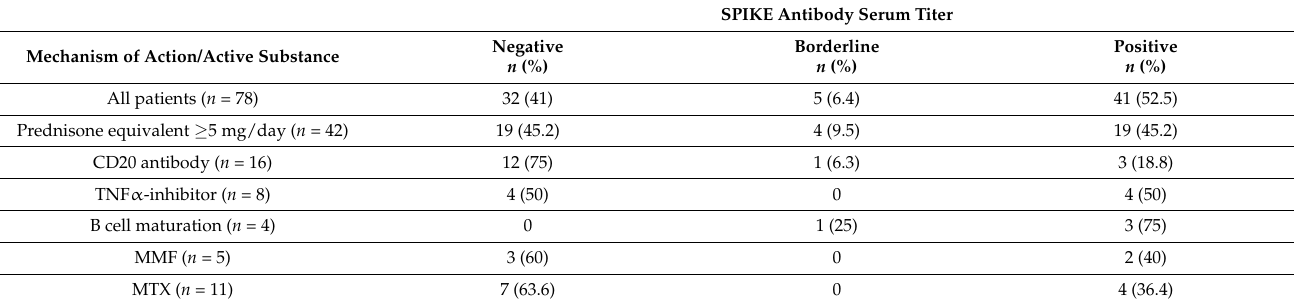
Table 2. Serostatus depending on the type of immunosuppressive therapy (SPIKE antibody serum titer: negative, IgG ratio < 0.8; borderline, IgG ratio ≥ 0.8 and < 3.2 (ratio considered positive, but insufficient); positive, IgG ratio ≥ 3.2. Abbreviations: TNF α , tumor necrosis factor; MMF, mycofenolate mofetil; MTX,